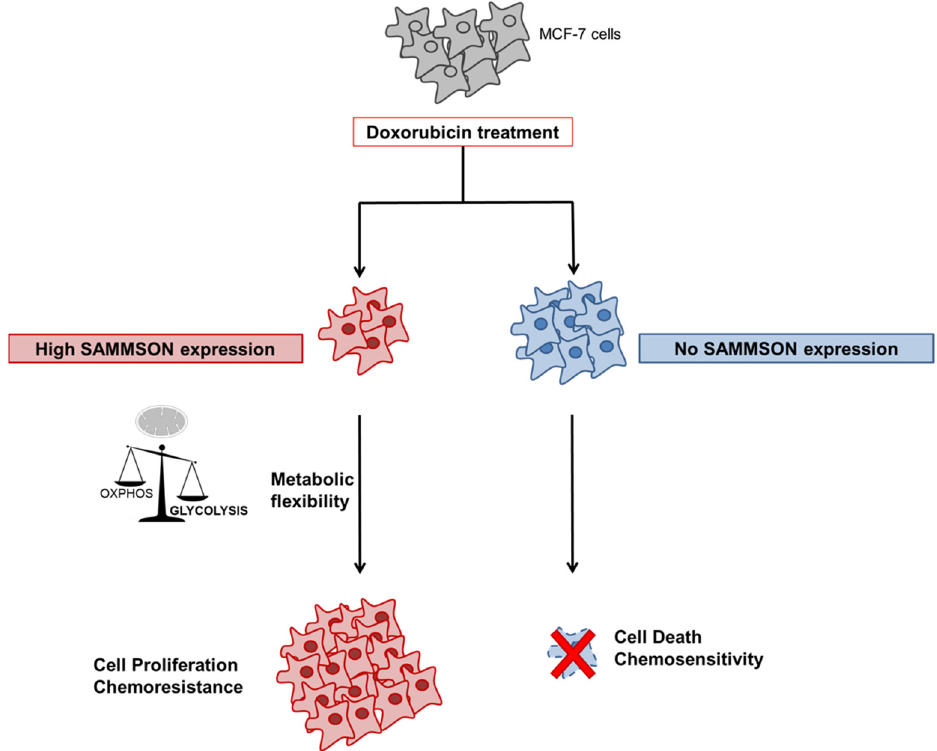
Figure 4. Schematic representation of the impact of SAMMSON on cellular metabolism and chemoresistance in MCF-7 cells. After doxorubicin treatment, in a pool of cells, high SAMMSON expression favors the Warburg effect with increased glycolysis and decreased mitochondrial respiration, resulting in increased resistance of these cells to doxorubicin.